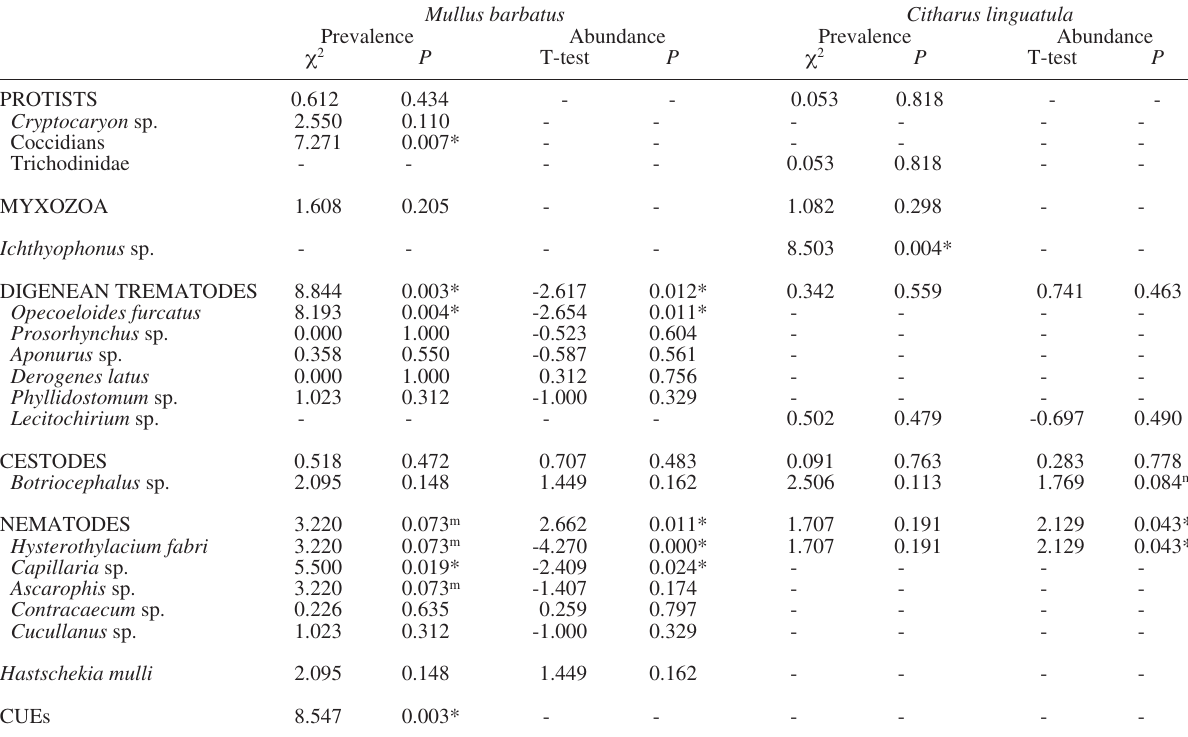
Table 4. – Chi-square and t test executed in the prevalence and abundance of parasites and CUEs between the two sites in Mullus barbatus and Citharus linguatula samples. t test analysis was applied in variables normalized by logarithmic transformation except for Hysterothylacium fabri and Nematoda. * Significant values ( P ≤ 0.05), m marginally significant values (0.05< P <0.10)